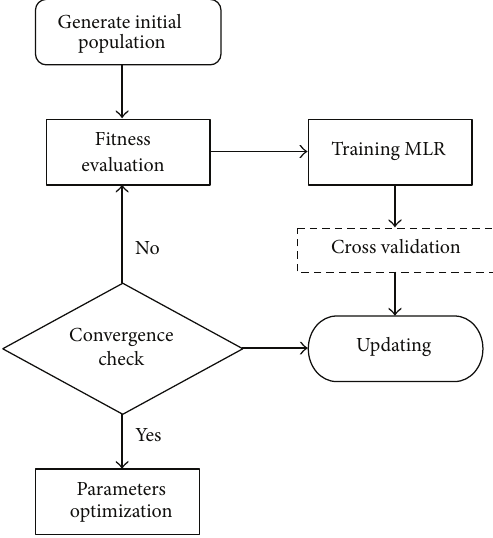
Figure 1: Flowchart of PSO